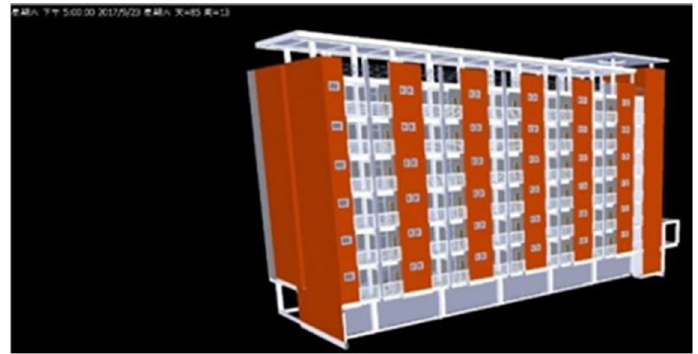
Figure 17. Progress of the project in week 13.